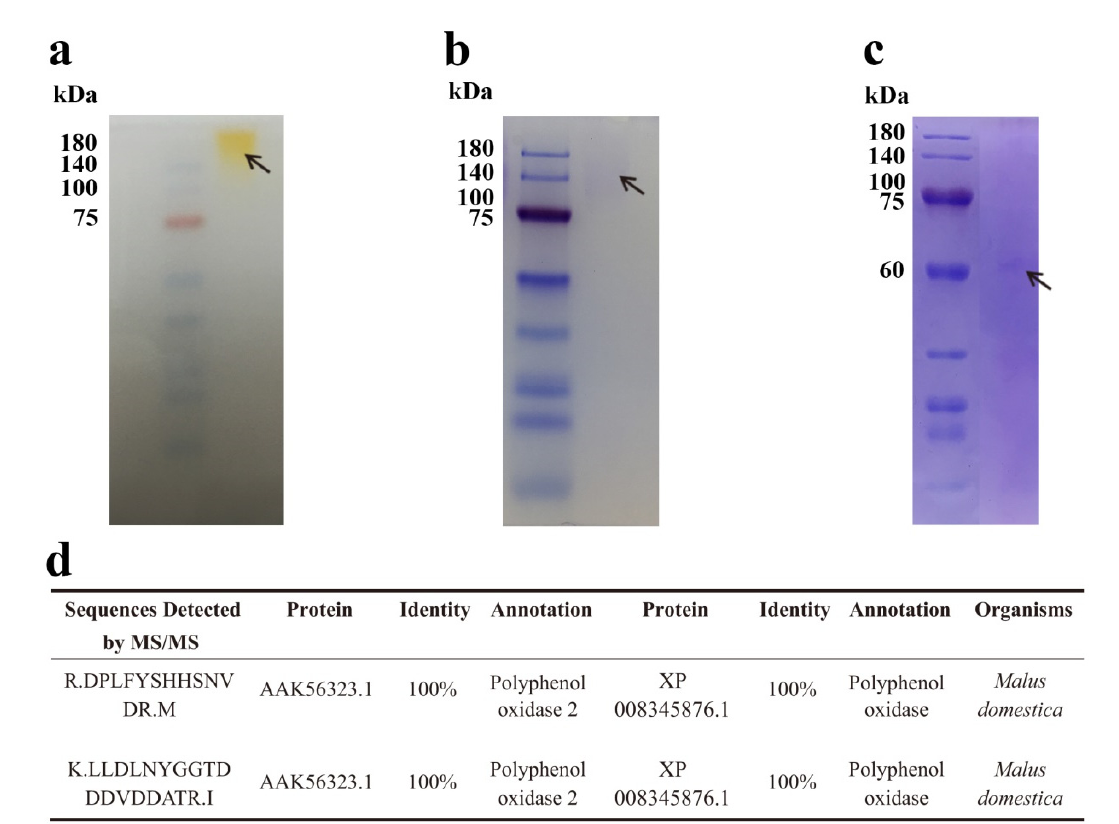
Figure 3. Electrophoresis analysis and sequencing of purified PPO from Huaniu peel. ( a ) Native- PAGE, ( b ) SDS-PAGE, and ( c ) urea-SDS-PAGE of purified faction after 3 steps of purification,